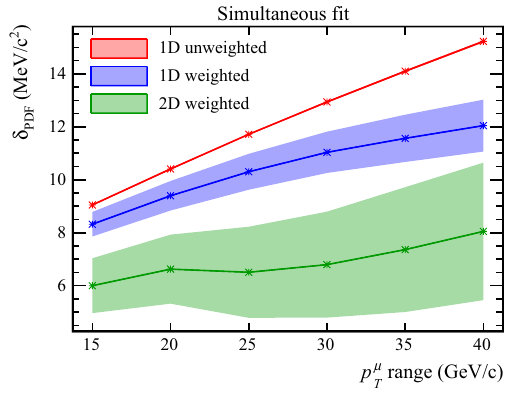
μ range (the full width, T